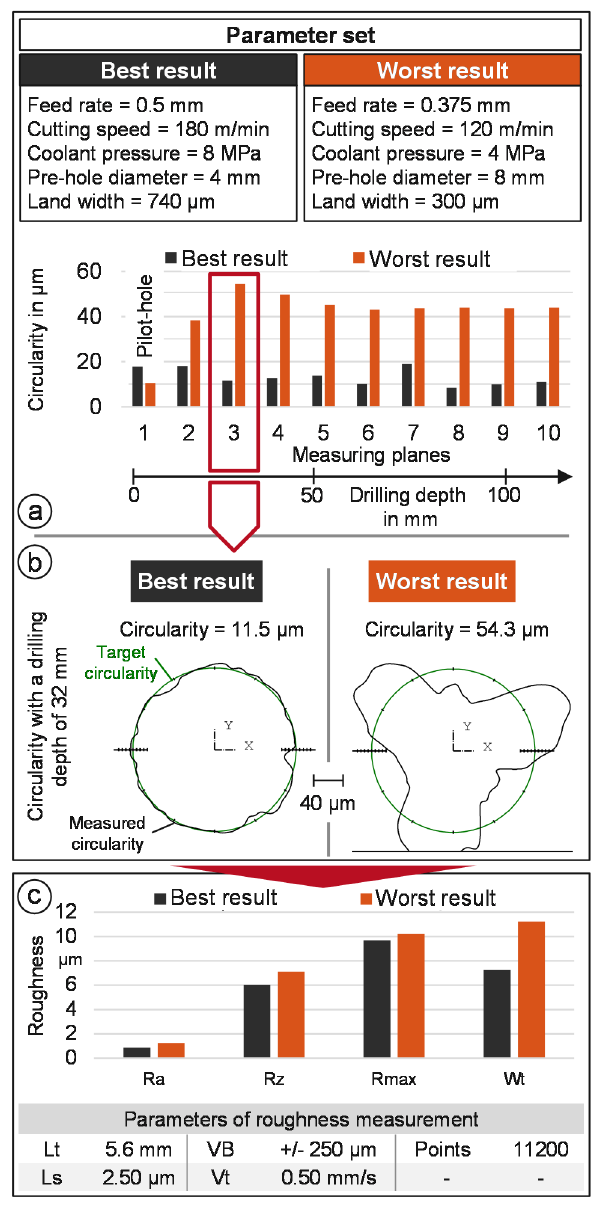
Figure 7. ( a , b ) Comparison of the best and worst result by the representation of the circularity and ( c ) the surface roughness.